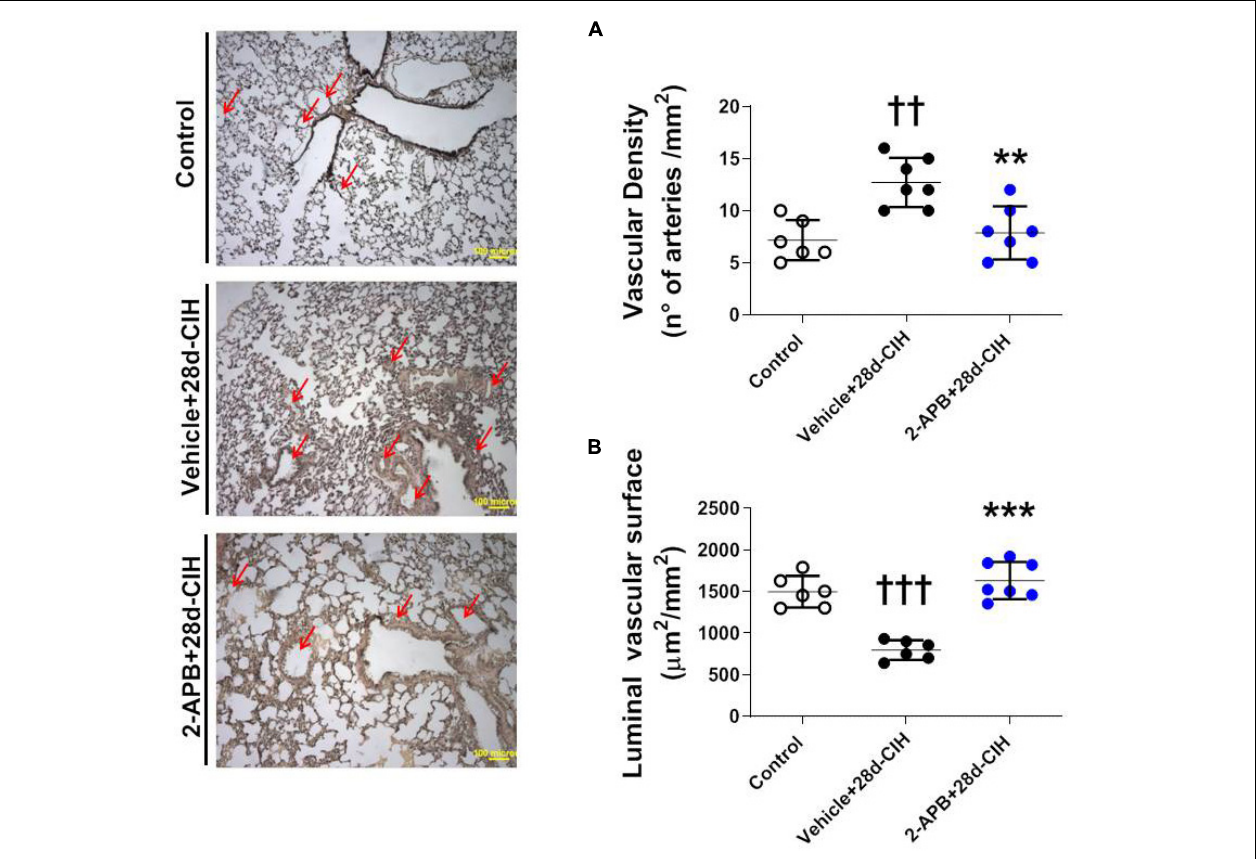
FIGURE 3 | Effect of 2-APB on vascular density and luminal surface in lungs of rats subjected to chronic intermittent hypoxia. Left panel, Reconstruction of 6 lung parenchyma slices stained with Van Gieson. (A) Vascular density (ANOVA, P = 0.0007). (B) Luminal vascular surface (ANOVA, P < 0.0001) in controls (empty circles, n = 6), Vehicle + 28d-CIH (black circles, n = 6), and 2-APB + 28d-CIH rats (blue circles, n = 7). Scale bar = 100 µ m. Mean ± SD. †† P < 0.01 vs. all groups, ††† P < 0.001 vs. all groups, ** P < 0.01 vs. Vehicle + 28d-CIH, *** P < 0.001 vs. Vehicle + 28d-CIH. One way ANOVA-followed by Newman Keuls tests.